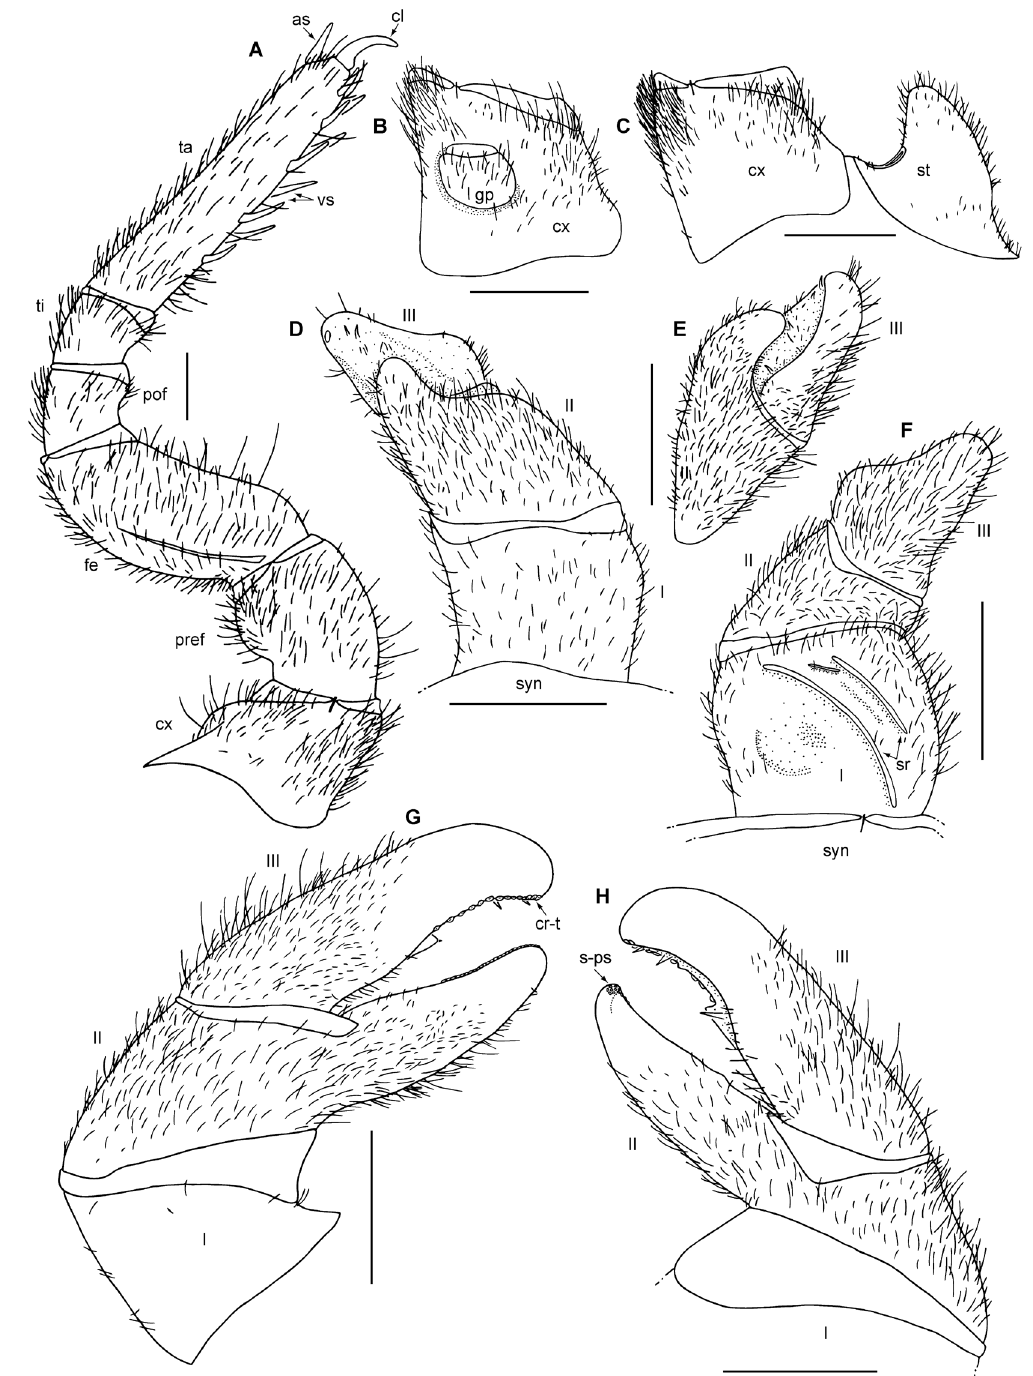
Fig. 8. Zoosphaerium beanka sp. nov., holotype (FMNH-INS 3119906). A . right leg 9, posterior view. B . Left coxa 2 with gonopore, posterior view. C . Left coxa 1 with stigmatic plate, posterior view. D . Left anterior gonopod, posterior view. E . Left anterior gonopod, lateral view. F . Left anterior gonopod, anterior view. G . Right posterior telopod, posterior view. H . Right posterior telopod, anterior view. Abbreviations: as = apical spine; cl = claw; cr-t = crenulated teeth; cx = coxa; fe = femur; gp = gonopore; pof = postfemur; pref = prefemur; s-ps = sclerotized spots; sr = stridulation rib; st = stigmatic plate; syn = syncoxite; ta = tarsus; ti = tibia; vs = ventral spines. Roman numerals indicate telopoditomeres. Scale bars = 1